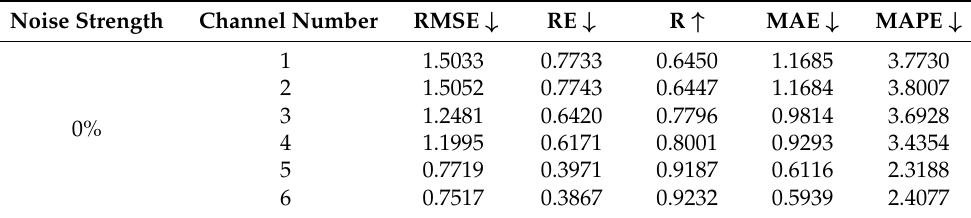
Table 7. Quantitative comparisons on different numbers of input channels. By changing the dimen- sion of the inputs of the network, the proposed method can fit different MISO configuration.